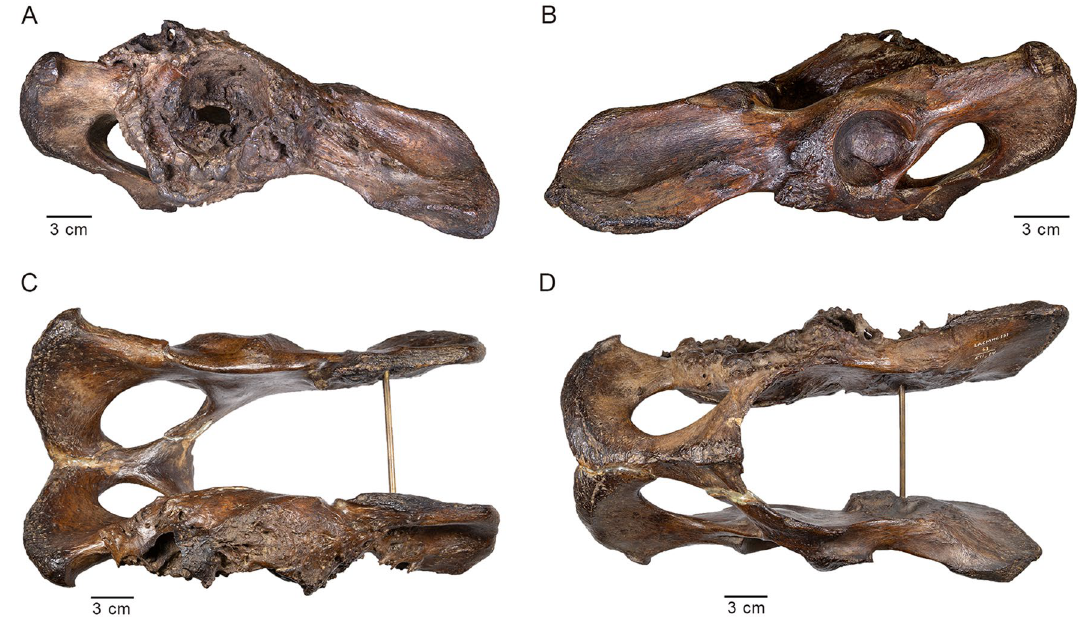
Figure 1. Photographs of LACMHC 131, a pathological pelvis belonging to Smilodon fatalis . ( A ) Right lateral view showing destruction of the acetabulum; anterodorsal end to the right. ( B ) Left lateral view showing the acetabulum intact but with exostoses around the anterodorsal rim; anterodorsal end to the left. ( C ) Dorsal and ( D ) ventral views showing asymmetry in the pelvis; anterior end to the